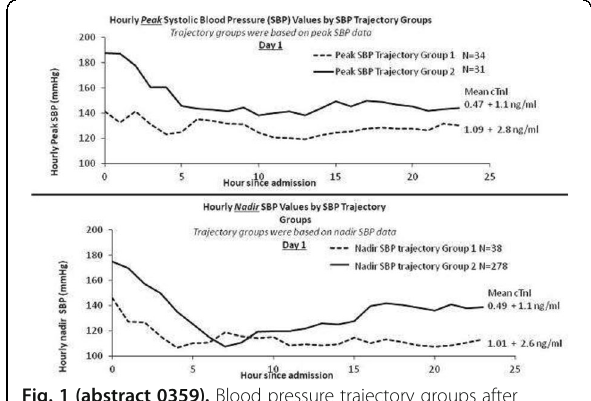
Fig. 1 (abstract 0359). Blood pressure trajectory groups after subarachnoid